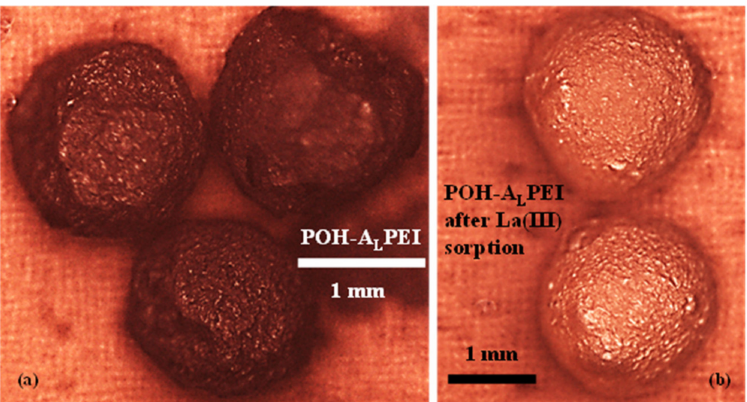
Figure 1. Photograph of sorbent particles—before ( a ) and after La (III) sorption ( b